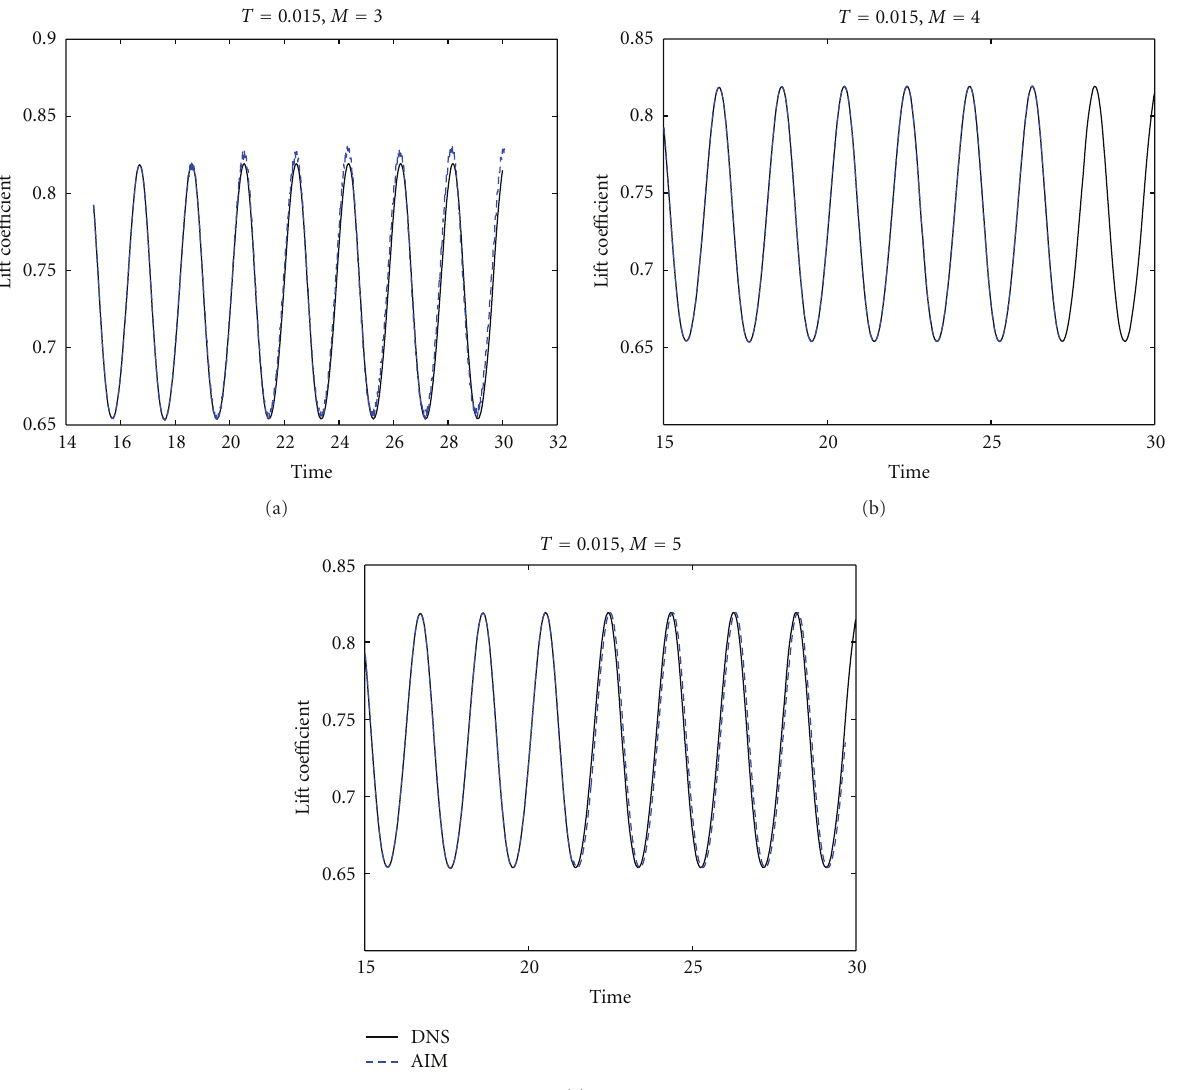
forward Euler’s method in this study. A single step of